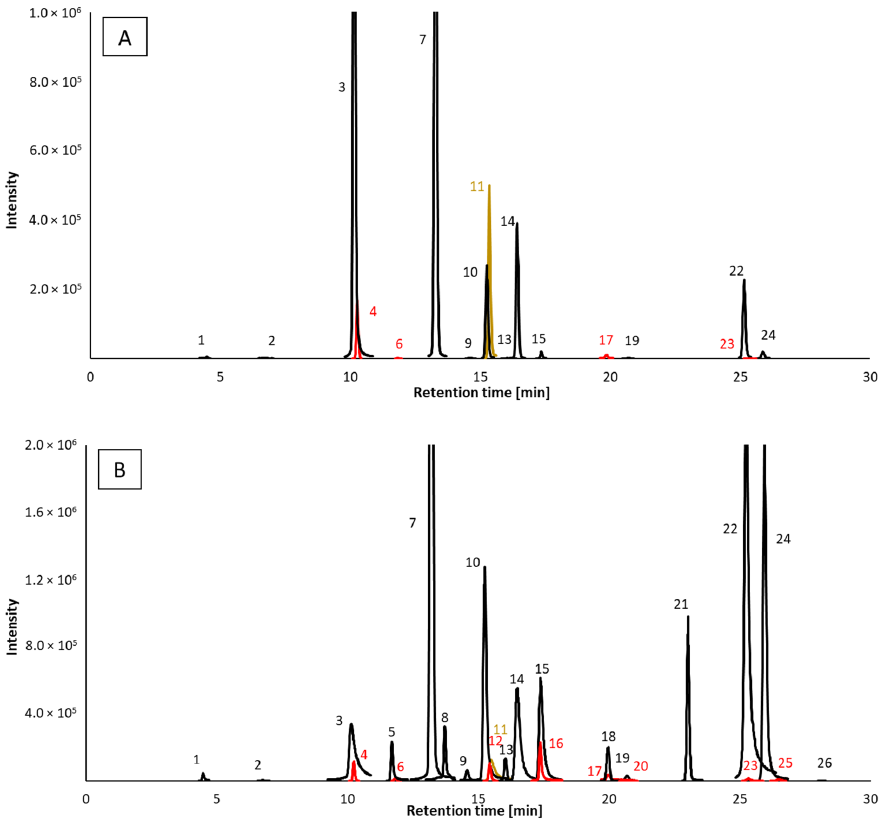
Figure 3. HPLC-MS/MS separations of phenolic compounds (( A )—sample No. 14; ( B )—standard